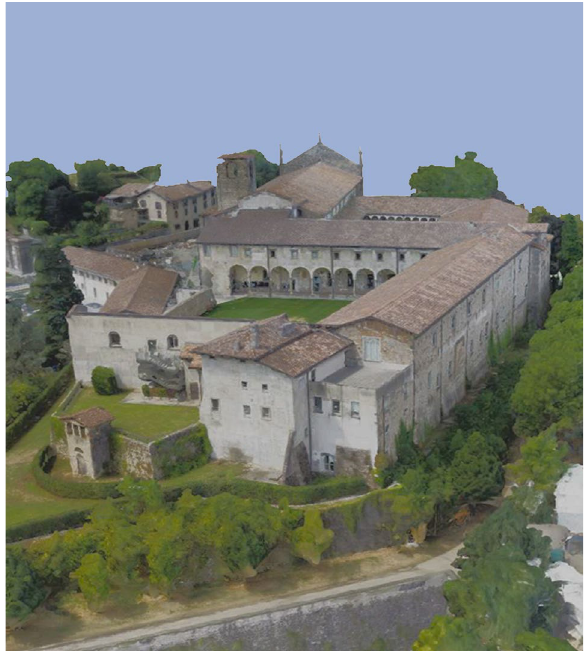
Figure 9. The complex of Sant'Agostino seen from the south.